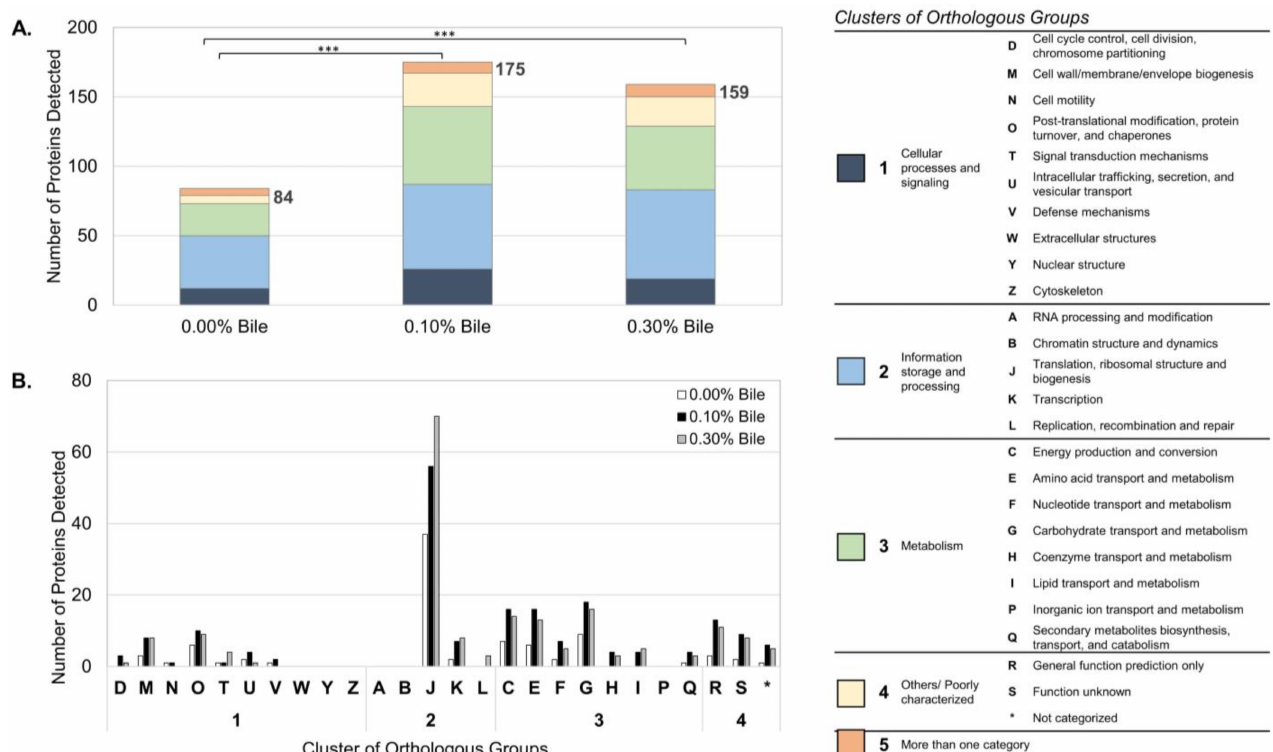
Figure 1. Composition and functional analysis of the Lactobacillus mucosae LM1 exoproteome under normal conditions (0.00% bile) and during bile treatment (0.10% and 0.30% bile), based on Clusters of Orthologous Groups, classified into ( A ) major and ( B ) specific functional categories. Tukey’s multiple comparisons test after ANOVA show protein secretion is significantly higher under bile treatment (*** p value < 0.001, n = 3). Specifically, proteins with COGs for [J] translation, ribosomal structure and biogenesis under [2] information storage and processing group of proteins were the most